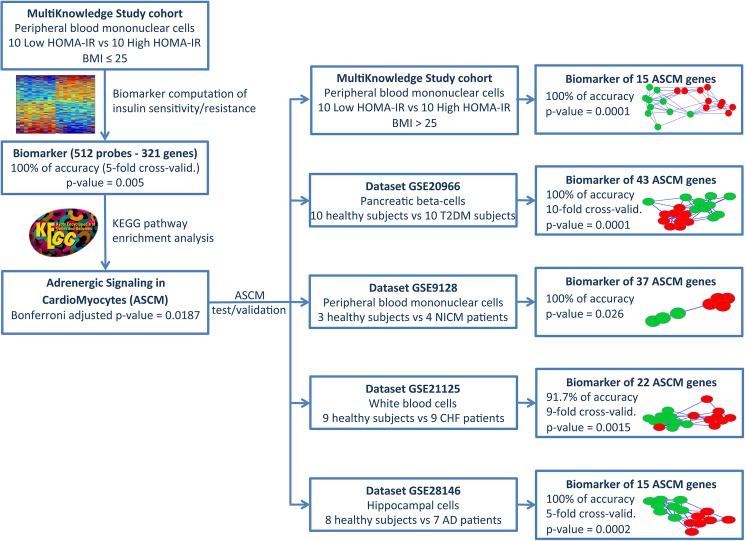
Block diagram reassuming the results of the paper.Starting from the MultiKnowledge population we identified a cohort of 10+10 subjects with normal BMI and opposite HOMA-IR value. We computed a biomarker able to discriminate between the two groups and we identified the ASCM pathway as the most significant pathway in the biomarker. We then validated this result in another cohort from the MultiKnowledge study of 10+10 subjects with BMI>25 and opposite HOMA-IR value. Finally, we identified genes in the ASCM able to discriminate between healthy controls and patients with T2DM, or CHF, or AD.